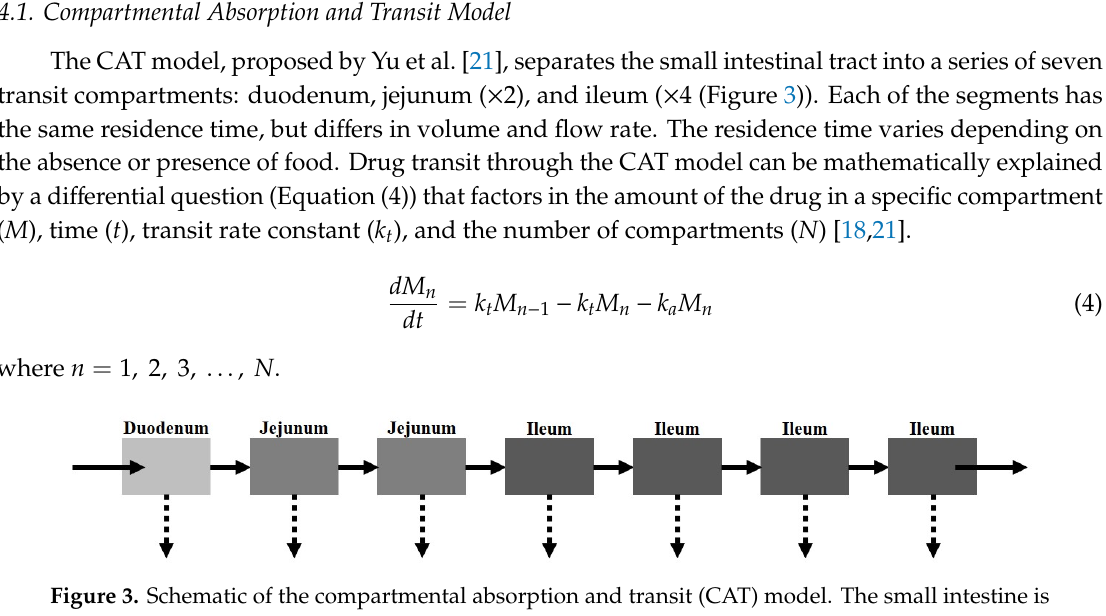
separated into seven compartments. The solid and dotted arrows represent the transit rate constant ( k t ) and absorption rate constant ( k a ),